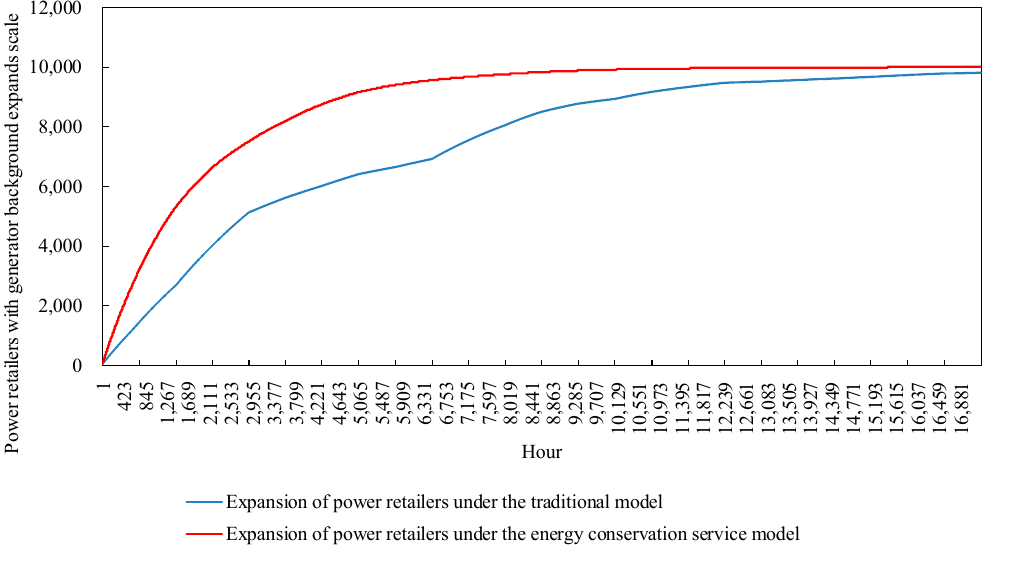
Figure 22. The comparison of the comparative expansion of power retailers under energy conserva- tion services.